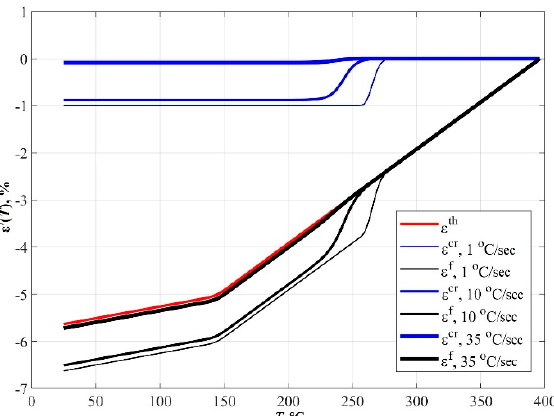
Figure 4. Temperature dependence of free deformation components of PEEK during cooling at different speeds. Black curves— ε f , red— ε th , blue— ε cr